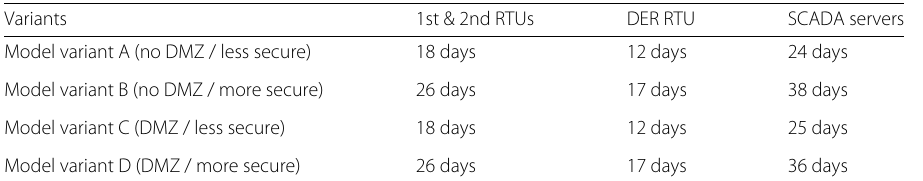
Table 5 Analysis results with an attacker positioned at the Energy Supplier Variants 1st & 2nd RTUs Model variant A (no DMZ / less